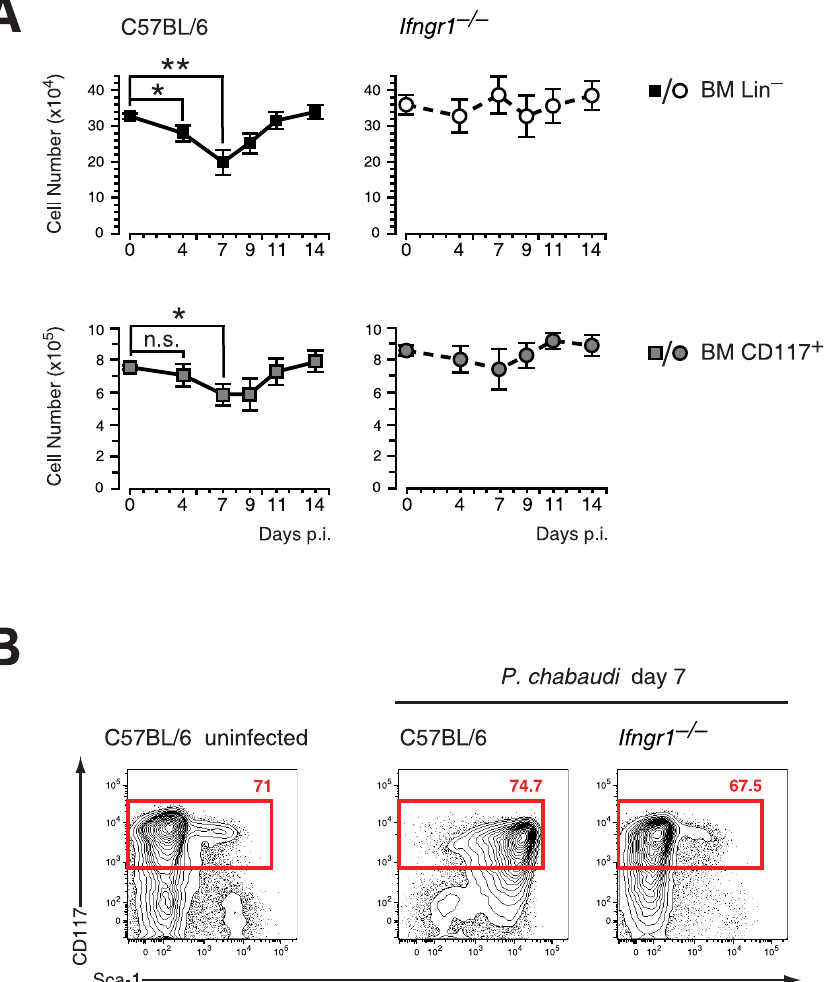
Figure 1. Contraction of lineage negative cell and Sca-1 upregulation in malaria are dependent on IFN- c signaling. A. Reduction of LIN 2 and c-Kit (CD117) positive cells in the BM during infection of C57BL/6 mice with P. chabaudi . Significant contraction of absolute numbers was recorded at day 4 and day 7 after infection for LIN 2 cells and at day 7 for c-Kit + cells. Ifngr1 -null mice did not undergo any significant loss of LIN 2 or c- Kit + BM cells during acute malaria. Data represent mean 6 SEM of cell number per femur/pair obtained from 15 infection experiments (C57BL/6) or four experiments ( Ifngr1 -null mice) each with 4–5 mice per group (*: P # 0.05; **: P # 0.01, Mann-Whitney U-test). B. LIN 2 BM cells from uninfected controls and malaria-infected animals at day 7 of infection with P. chabaudi were co-stained with c-Kit and Sca-1. Of note is the lack of Sca-1 upregulation on Ifngr1 -null cells during acute malaria. Data are representative for 19 infection experiments (C57BL/6) or four experiments ( Ifngr1 -null mice) each with numbers in individual plots indicating the frequency (in %) of the respective population.